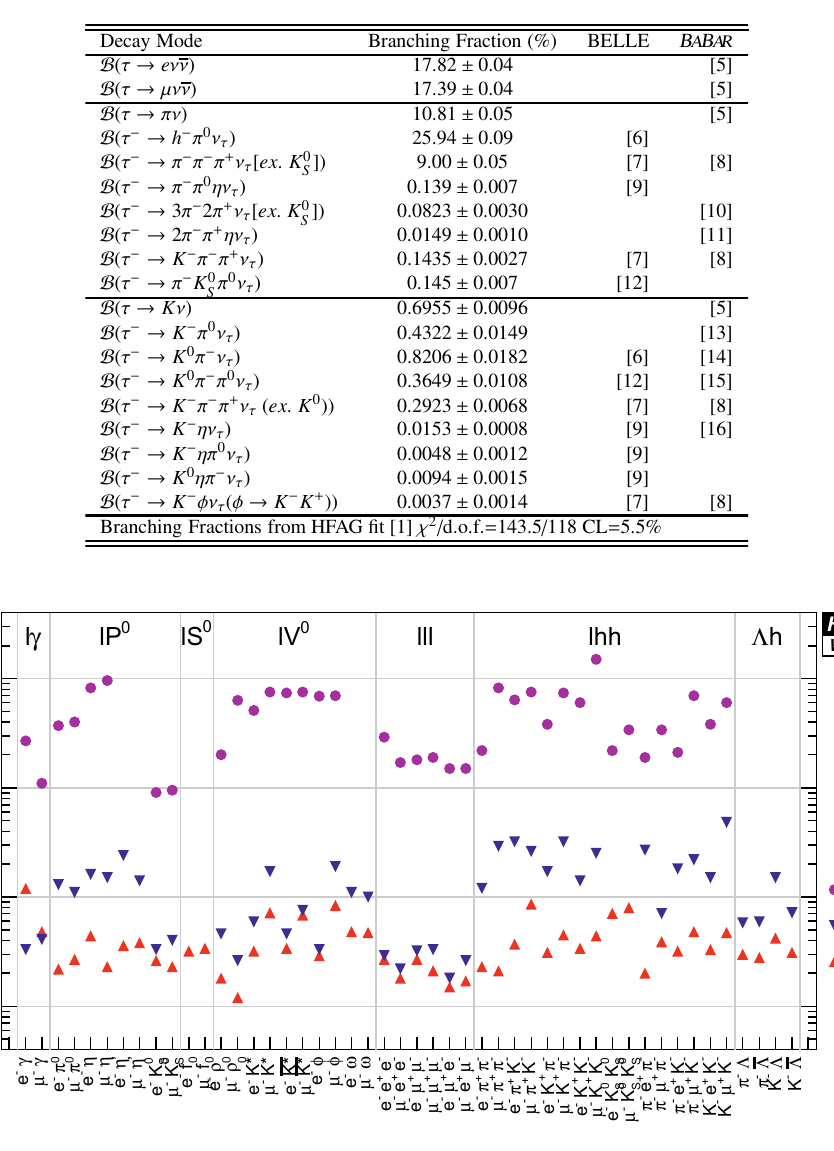
Table 1. The HFAG fit branching fraction for both strange and non-strange τ decays which were measured by the B-Factories [1]. A more complete list of decay modes measured by B A B AR and BELLE can be found in [1].